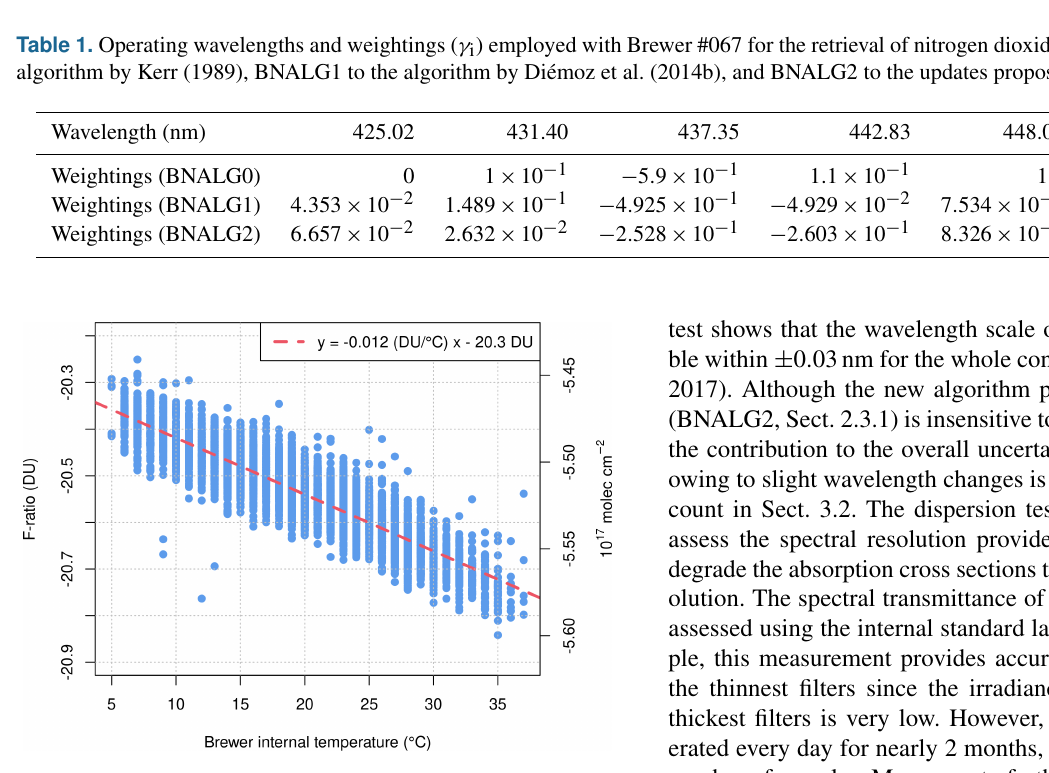
Figure 1. Results from the standard lamp (SL) test (blue dots, “F-ratio”) in both Dobson units (DU; left axis) and molecules per square centimetre (molec . cm − 2 ; right axis), as a function of the Brewer internal temperature. The slope of the regression line is used in BNALG2 to correct the Brewer sensitivity to the internal temper- ature in solar measurements. Only variations (differences) in the SL results on the y axis, and not their absolute values, have a physical